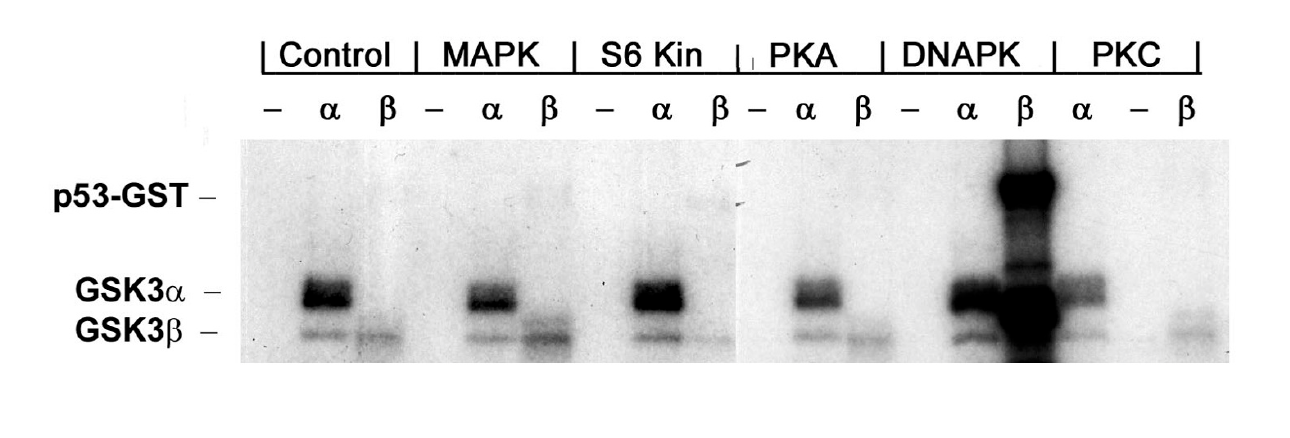
Figure 1 Phosphorylation of p53 by GSK3 β . p53-GST (2 µ g) was incubated in the absence (Control) or presence of the indicated protein kinase as described in methods. Primary kinases were then heat inactivated (65 ° C/15 min). Aliquots of the phosphor- ylated p53-GST were then incubated in the absence (-), or presence of recombinant GSK3 α ( α ) or GSK3 β ( β ) and 10 µ Ci 32 P- ATP. Phosphorylated p53-GST (0.25 µ g total p53-GST was detected by SDS-PAGE followed by auto-radiography. MAPK, MAP kinase; S6 Kin, S6 Kinase; PKA, Protein Kinase A; PKC, Protein Kinase